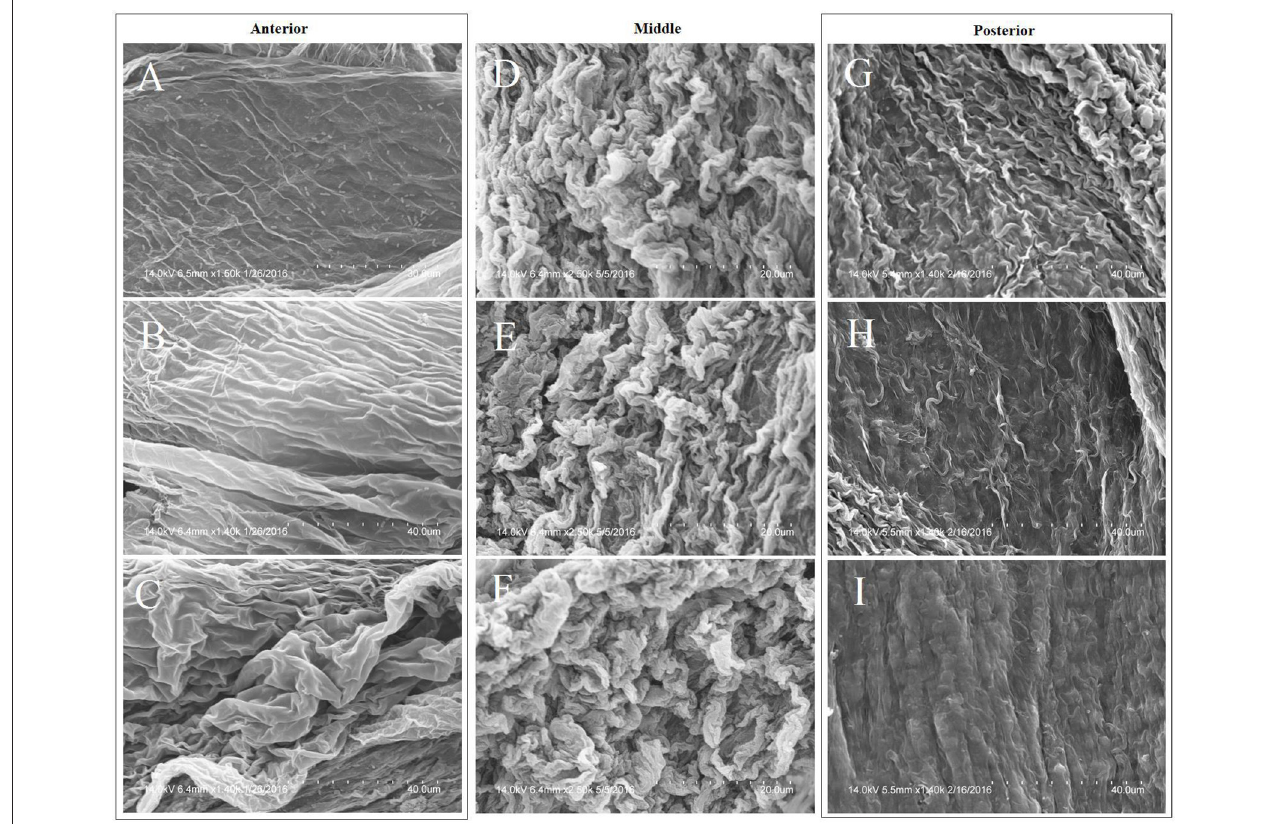
FIGURE 3 | Morphological variation in the anterior, middle, and posterior sections of the PM of a cabbage-raised T. ni midgut per regional characteristics: left column = anterior; middle column = middle; right column = posterior. Magnification of images are: (A) = 1,500 × ; (B) = 1,400 × ; (C) = 1,400 × ; (D–F) = 2,500 × ; (G–I) = 1,400 × . Images (A–I) are in spatial, sequential order along the length of the midgut.